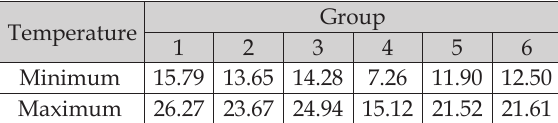
Table 5. Means for temperatures measured in the 6 groups of 8